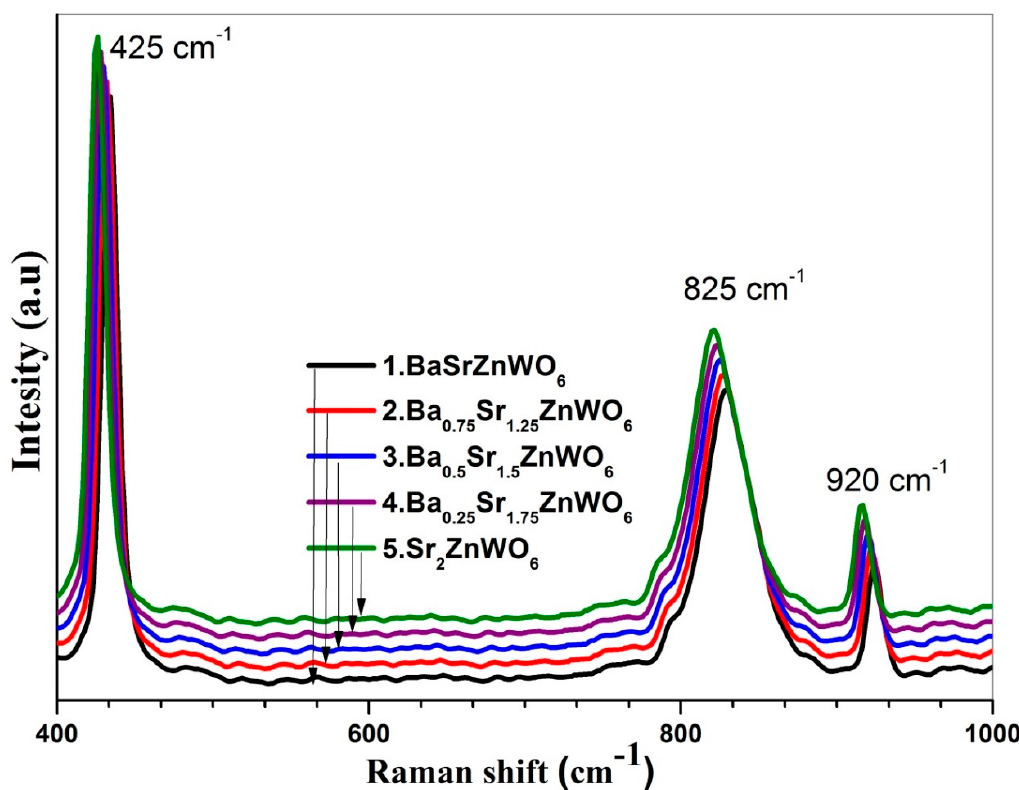
Figure 7. Raman shift spectra of the Ba 2 − x Sr x ZnWO 6 (x = 1, 1.25, 1.50, 1.75, 2) double perovskite series.